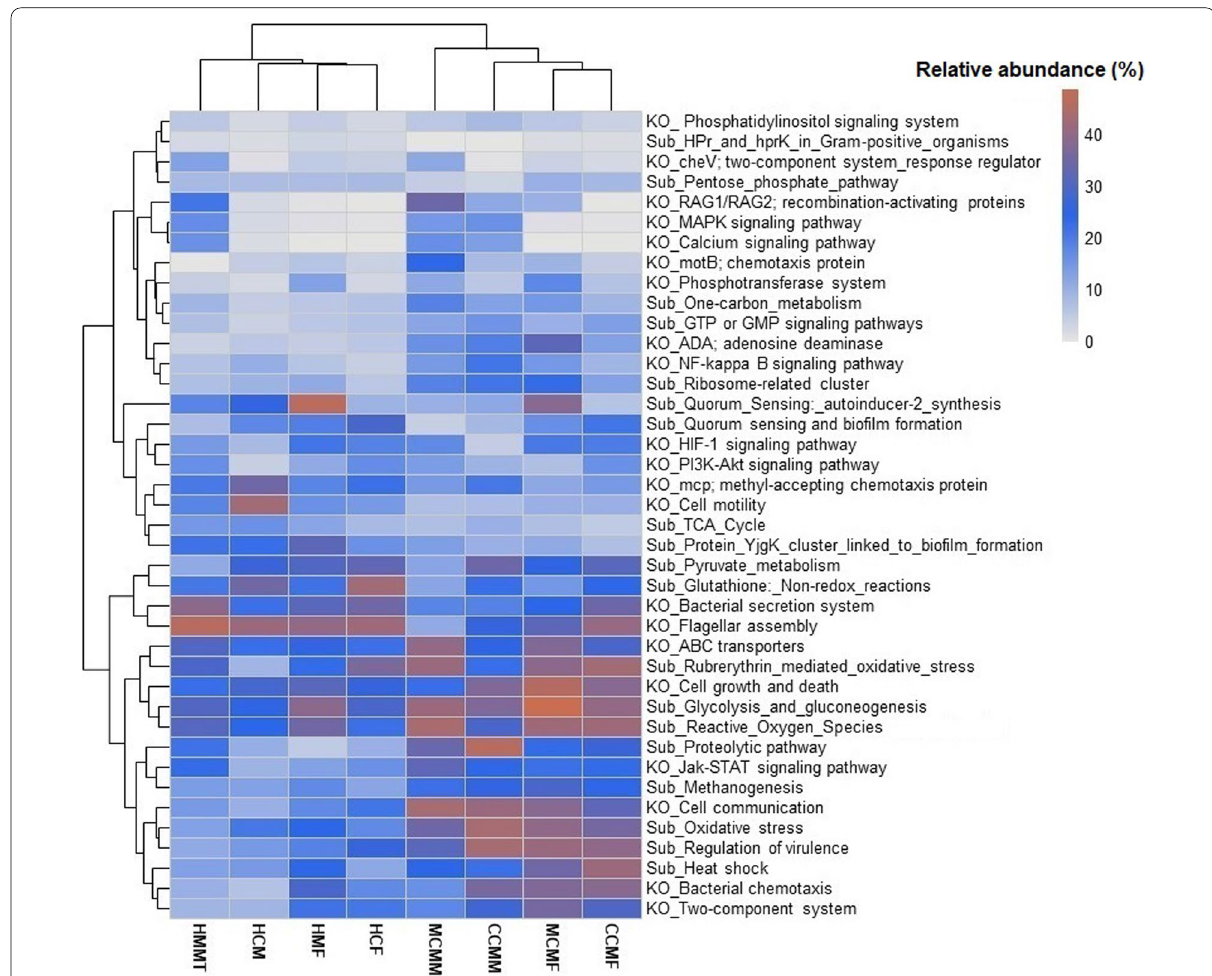
Fig. 9 Functional annotation of the cow and mouse mastitis (CCMM, CCMF, MCMF, MCMMT) and healthy (HCM, HCF, HMF, HMMT) sample related sequences. Heatmap representing hierarchical clustering of the predicted KEGG Orthologs (KOs) and SEED subsystem (Sub) functional pathways of the microbiome based on the average relative abundances across eight metagenome groups (CCMM, CCMF, MCMF, MCMMT) and healthy (HCM, HCF, HMF, HMMT). The color bar (light blue to dark red) at the top right-hand of the heatmap represent the relative abundance of putative genes expressed as a value between 0 (lowest abundance) and 40 (highest abundance) in each sample category. The dark red color indicates the more abundant patterns, whilst light blue cells account for less abundant putative genes in that particular metagenome. More information on the predicted metabolic functional potentials of the microbiomes in the study metagenomes are also available in Additional file